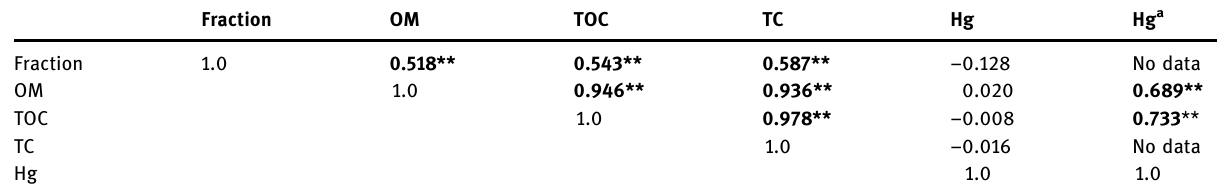
The bold values represent statistically signi fi cant correlation. **Correlation is signi fi cant at the ≤ 0.01 level. a Correlation for soil